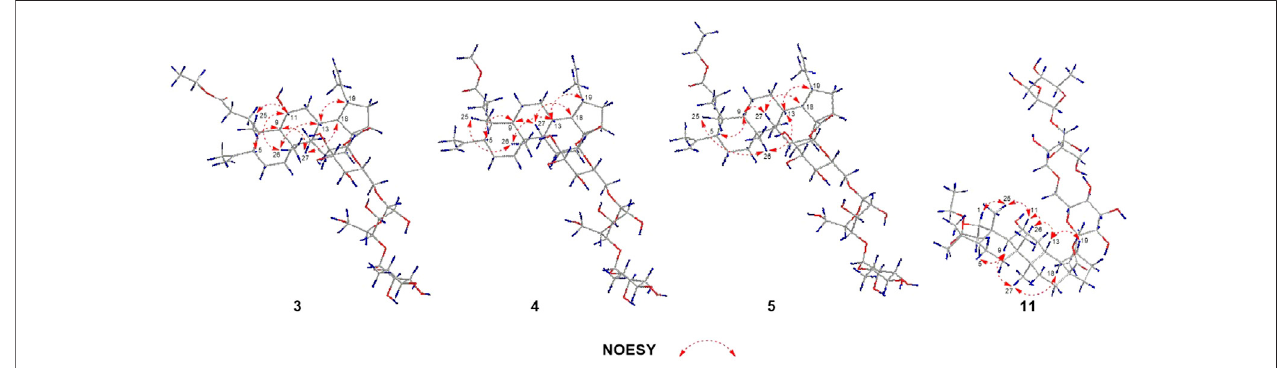
FIGURE 6 | Key NOESY correlations of compounds 3 - 5 , 11